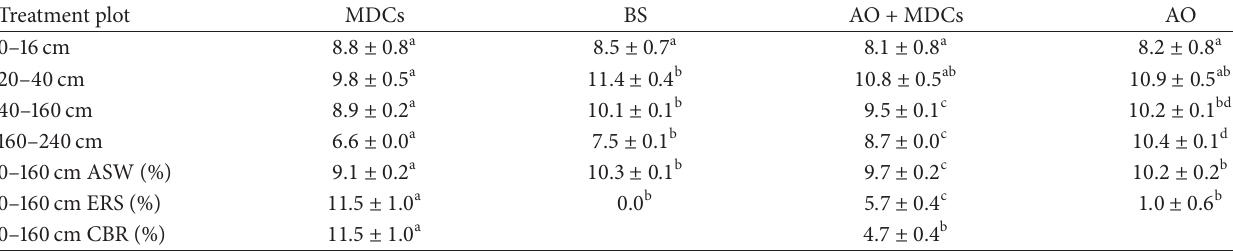
Note: different letters in the same column indicate significant differences at 5% probability level. Average soil moisture content, ASW. Efficiency of reducing soil moisture content = (1 − soil moisture content in current treatment/soil moisture content in BS) × 100, ERS. Contribution of MDCs to reducing soil moisture content = ((1 − soil moisture content in current treatment with MDCs/soil moisture content in BS) − (1 −